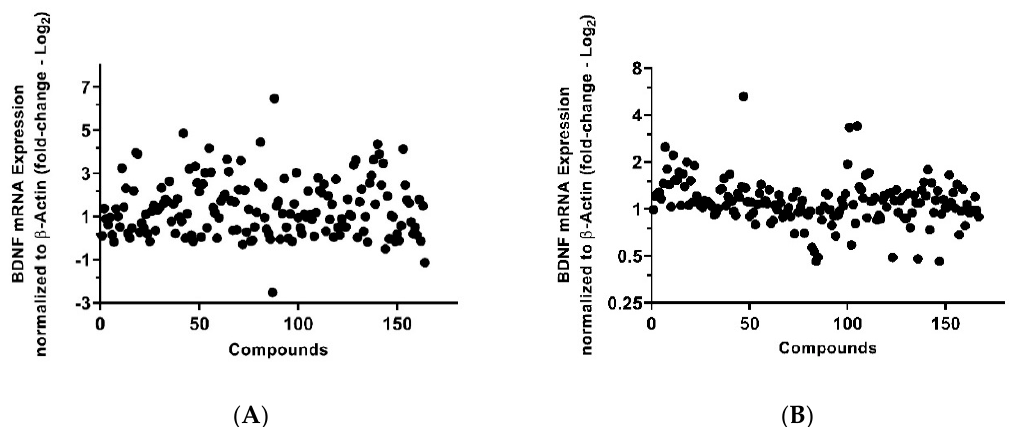
Figure 1. Scatterplot of the effect of Epigenetics Library compounds (1 µM, 0.1% DMSO) on the BDNF mRNA expression. ( A ) The primary screen in HNPCs against 164 epigenetic compounds. 67 potent BDNF expression effectors (activator and inhibitor) were identified. Z-factor = 0.55, Hit rate = 39.39%, Coefficient of variation = 2.48%; ( B ) The primary screen in human fibroblasts against 167 epigenetic compounds. 57 potent BDNF expression effectors (activator and inhibitor) were identified. Z-factor = 0.046, Hit rate = 34.73%, Coefficient of variation = 4.51%. Data points are the average of duplicates expressed as fold change (Log 2 ) BDNF mRNA expression relative to the control (DMSO 0.1%). The threshold for selection of hits for activators was set at 3 SD from the mean ( ≥ 1.4-fold change).